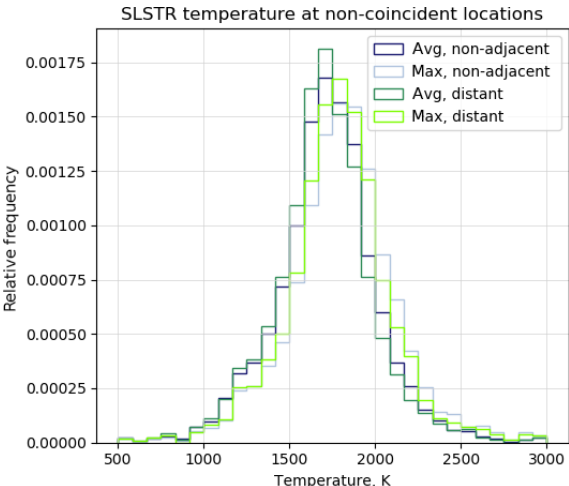
Figure 19. Average and maximum SLSTR-based temperature dis- tributions at VNF non-adjacent (the VNF flaring location is ≥ 2 grid cells away from the closest SLSTR-based flaring location) and dis- tant ( > 4 grid cells away) locations. The similar temperature distri- bution between the different types of flaring sites supports the argu- ment that the discrepancy in the number of flaring sites is not due to the temperature criterion but to the observation criterion, which can be traced back to less observation opportunities.